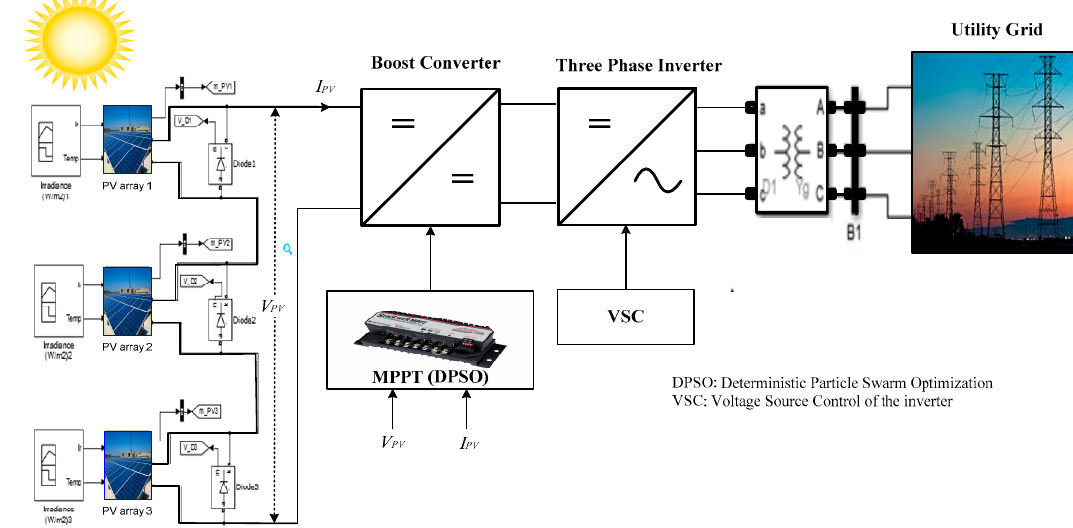
Figure 2. Multi-PV grid-connected system with conventional boost converter (CBC).